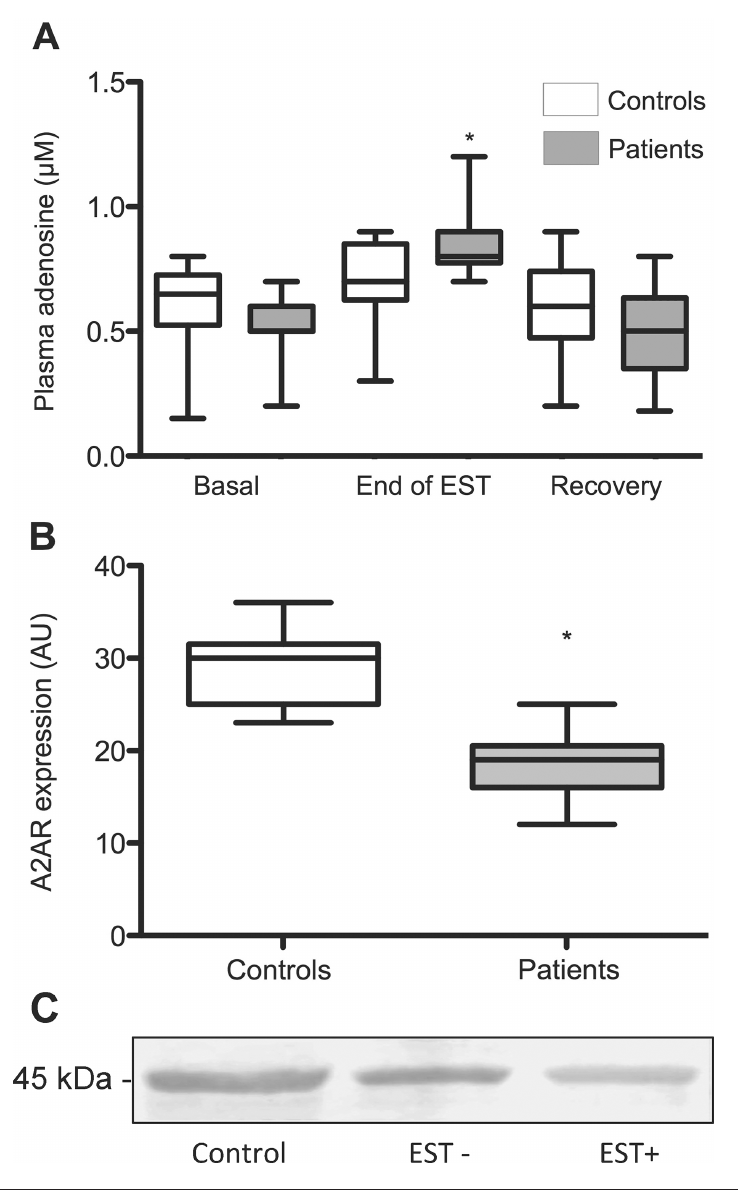
figure 1. Purinergic profile of CAD patients and controls. (A) Adenosine plasma concentration (APC) in basal conditions, at the end of EST and after a 10-min recovery period was measured in 17 CAD patients and 17 controls (*: P < 0.01 compared with basal state). (B) A receptor expression was evaluated using Western blotting in 2A 17 controls and 17 CAD patients (*: P < 0.01). Data (AU) are expressed as mean, me- dian and IQR. (C) Western blot analysis of A R expression in a representative sample 2A close to the mean value of each group of interest (Controls, EST–/EST+ patients) are Western blot analysis of cell lysates and probing with the anti-A R monoclonal 2A antibody Adonis prior to densitometry analysis of the 45-kDa band. At the basal state, A R expression was 37% lower in 2A